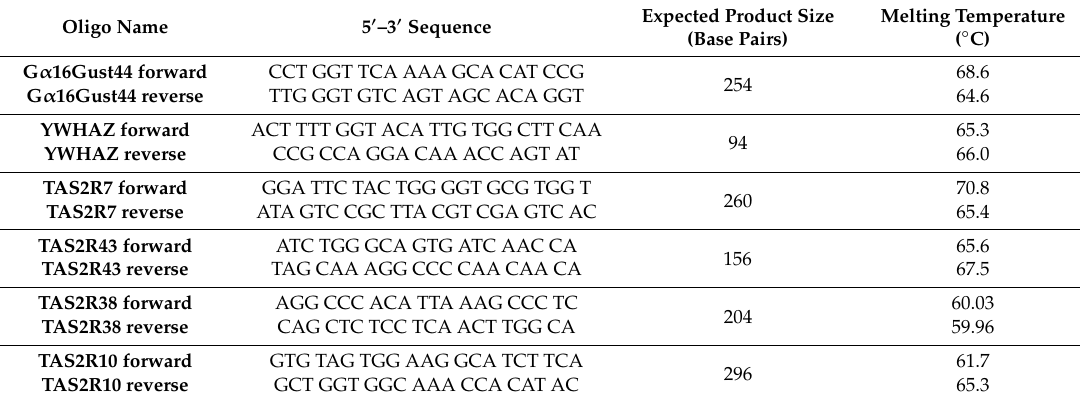
Table 1. Oligonucleotides